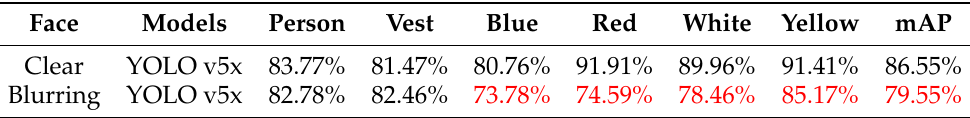
Table 9. Correctness of blurring face test on YOLO